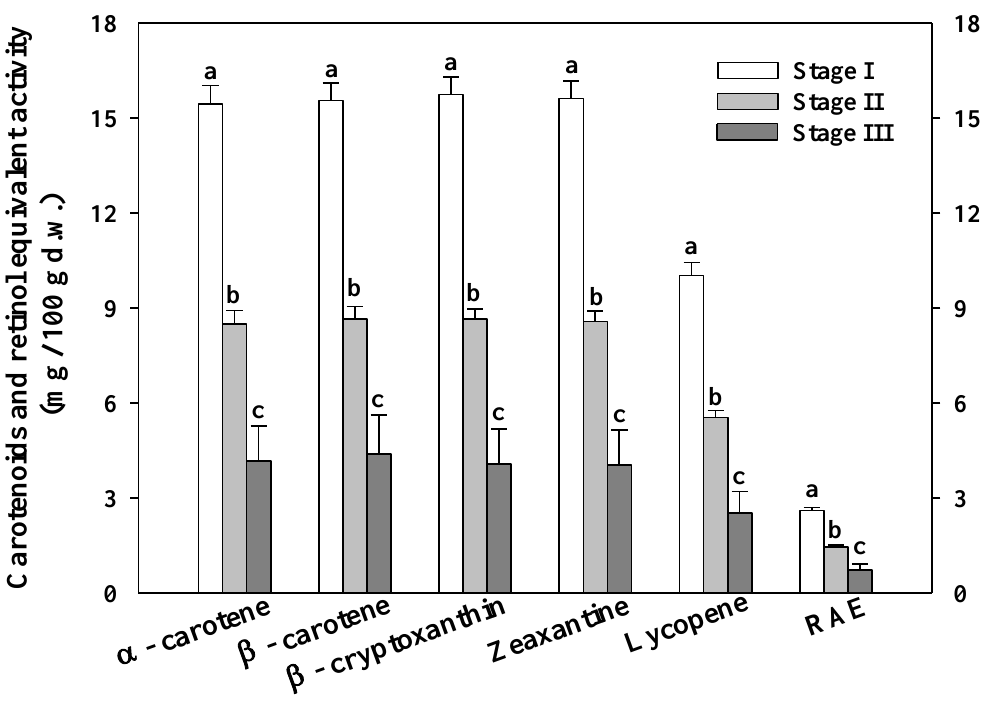
Figure 3. Carotenoids content and retinol activity equivalent (RAE) at different maturity stages of Aloe vera flowers. Stage I: immature; Stage II: mature; Stage III: mature, with flowers buds opened (mean ± SD, n = 3). a–c Different letters show significant differences ( p < 0.05) among the maturity stages.